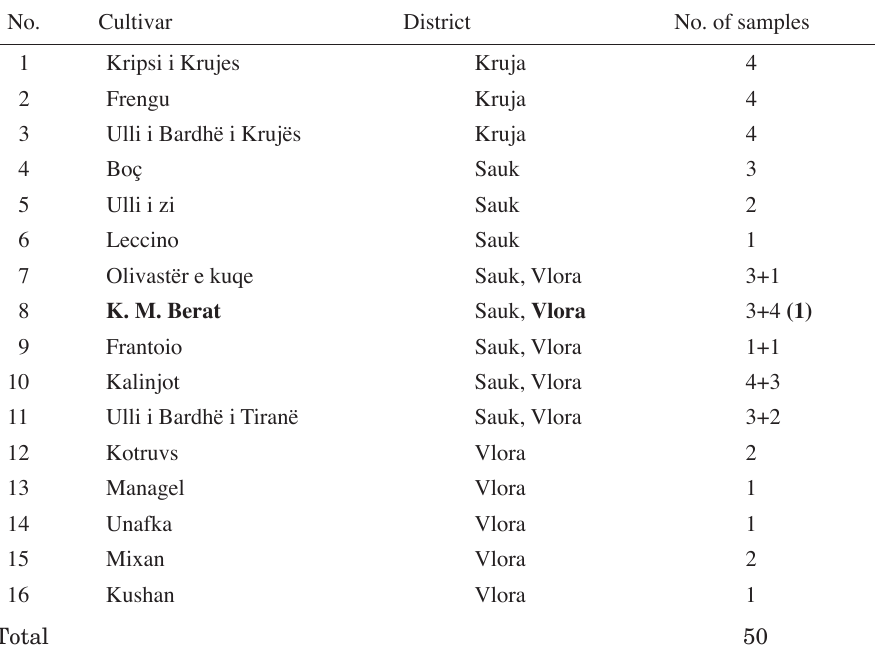
Table 1. List of olive samples collected and analyzed. The sample that was positive to SLRSV and OLYaV is shown in